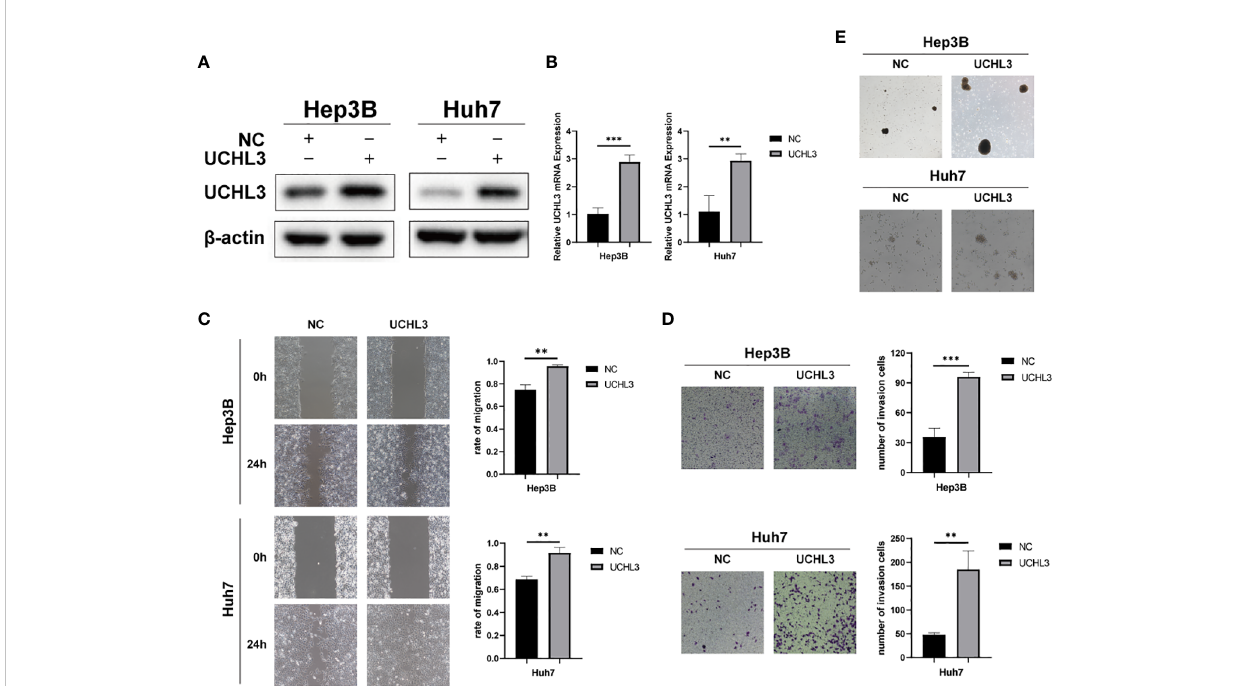
FIGURE 2 Overexpression of UCHL3 promoted HCC cell migration and stem-like properties. (A) UCHL3 overexpression shown by Western blots of Hep3B and Huh7 cells. (B) Levels of UCHL3 mRNA in Hep3B and Huh7 cells were con fi rmed by RT-qPCR. (C) UCHL3 overexpression promoted Hep3B and Huh7 migration, as shown by wound healing assay. (D) UCHL3 overexpression promoted Hep3B and Huh7 migration, as shown by Transwell assay. (E) UCHL3 overexpression promoted spheroid formation in Hep3B and Huh7 cells. **p < 0.01, ***p <